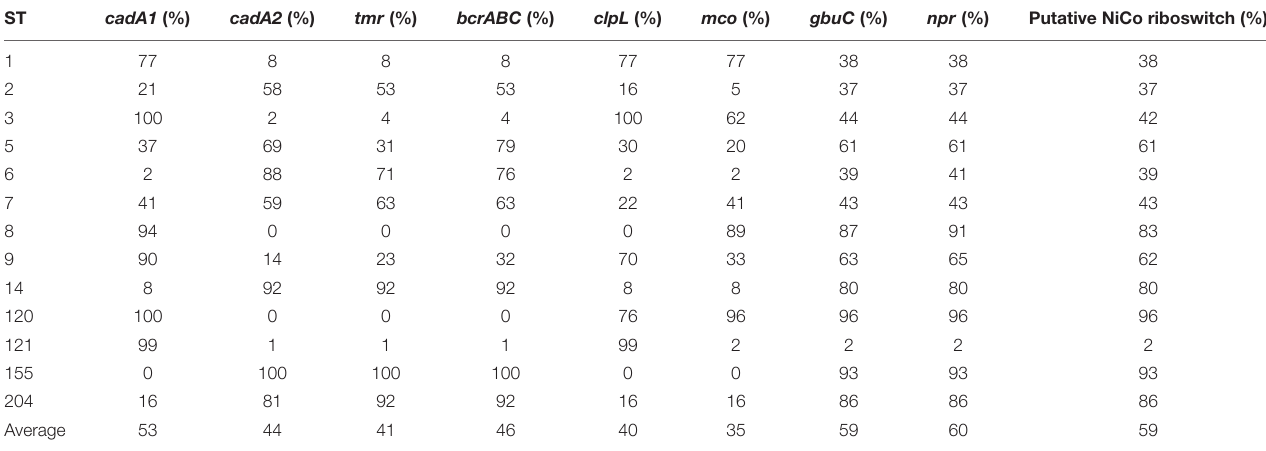
TABLE 4 | Percentage of selected plasmid-encoded stress response genes by ST based on BLASTn.